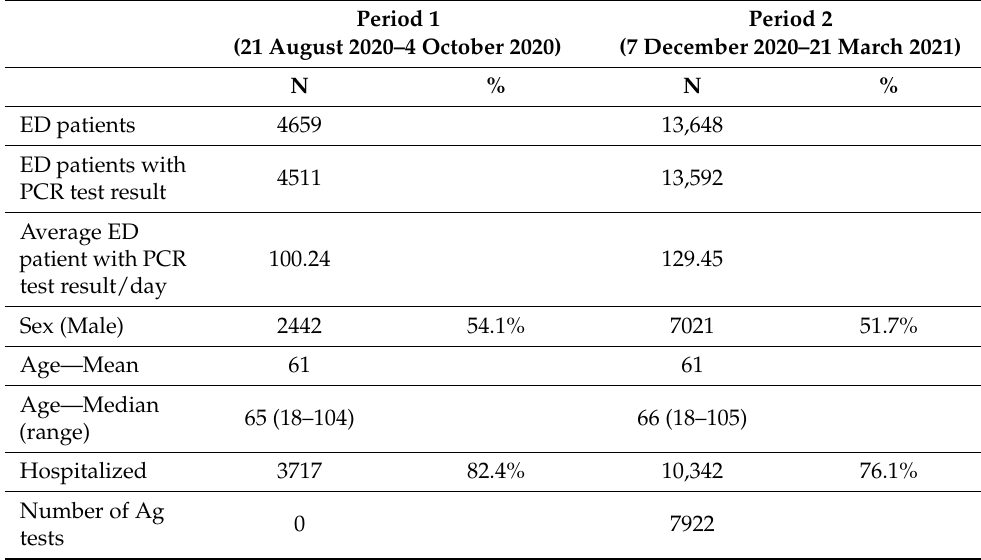
Table 1. Study population.